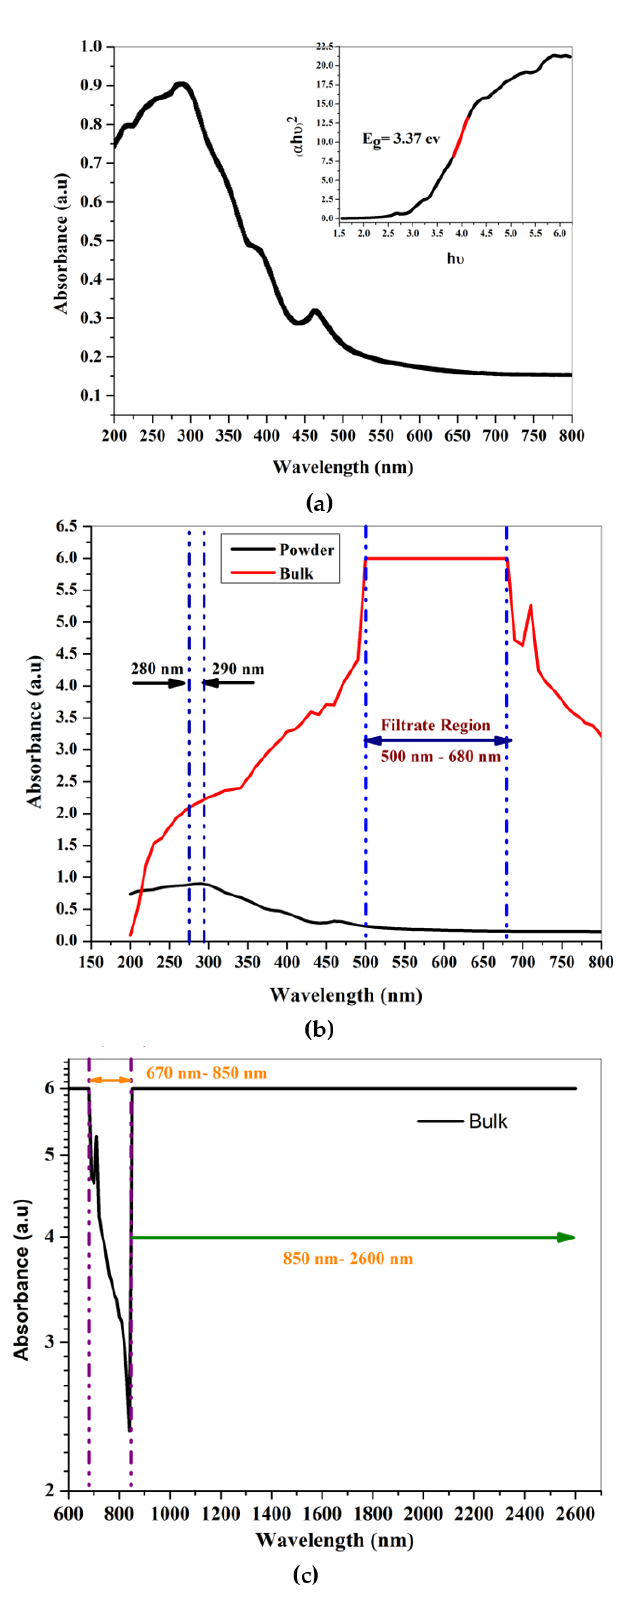
Figure 6. UV visible NIR spectra of ( a ) gahnite ferroan composite in powder form; ( b ) gahnite ferroan composite in powder and bulk form for comparative study and ( c ) gahnite ferroan composite of bulk sample beyond 600 nm wavelength.